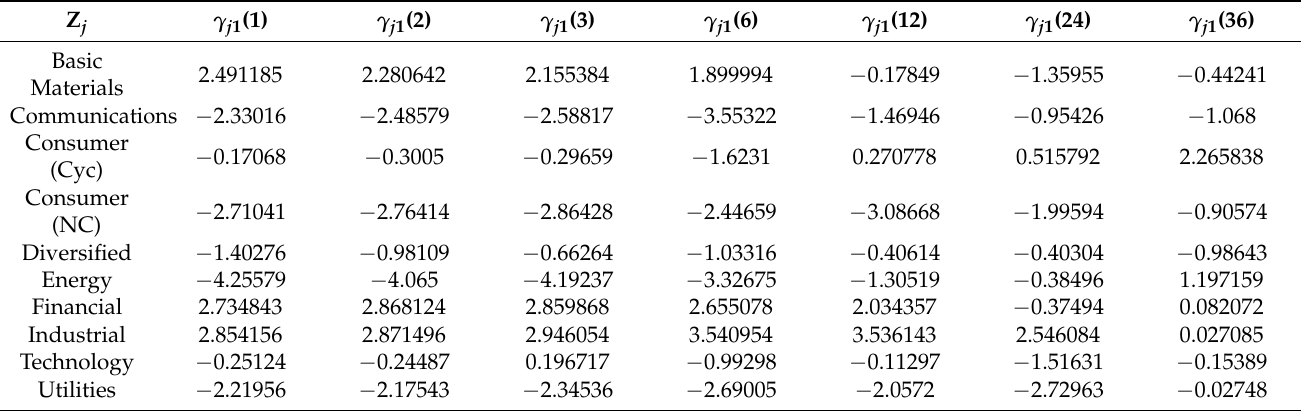
Table 2. Maximum pseudo-likelihood estimates for γ j 1 (l)